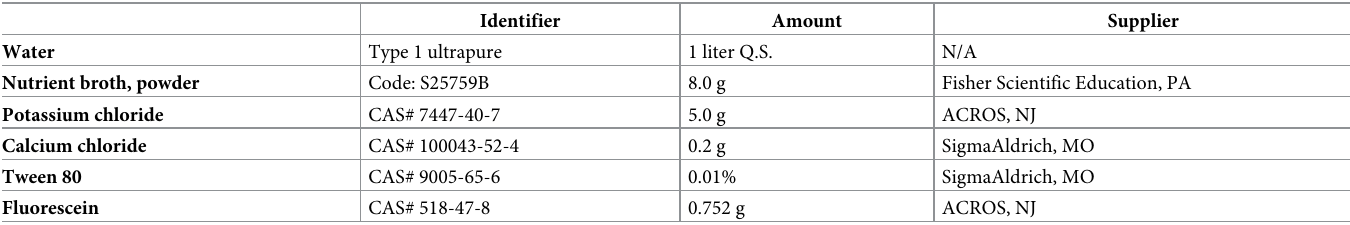
Table 3. Nutrient broth challenge solution used for liquid and viral penetration